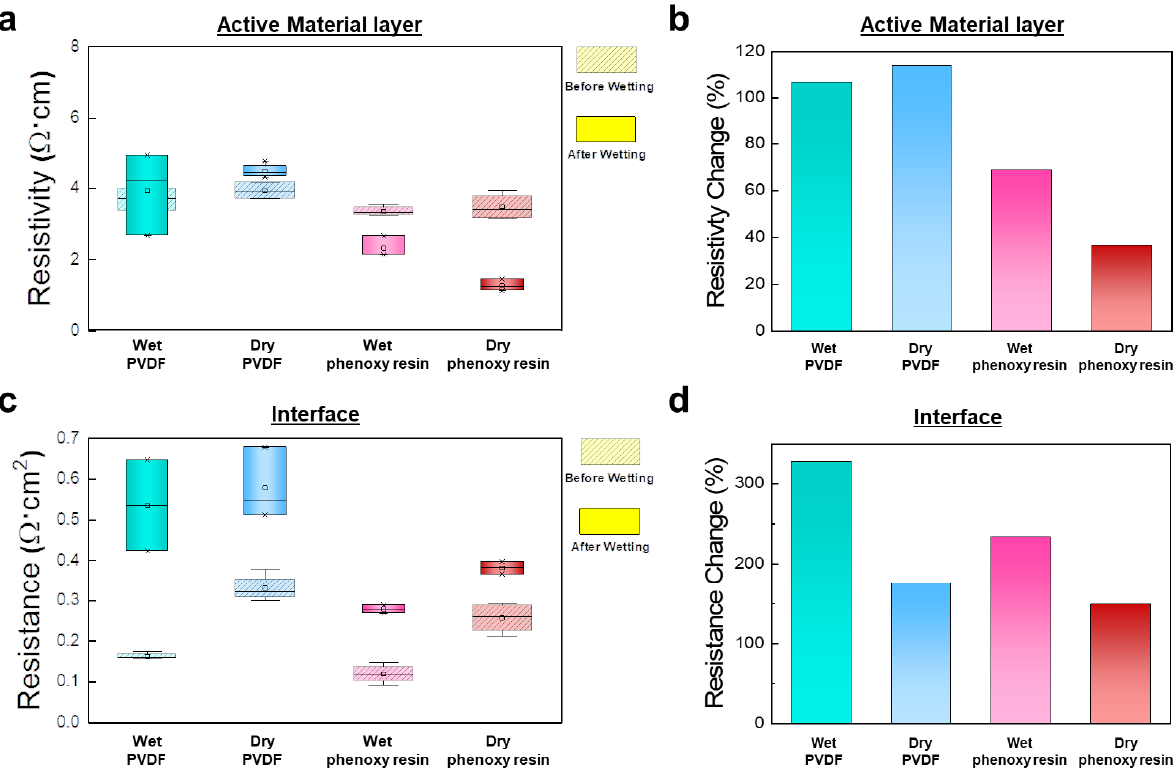
Figure 4. Resistivity of the active material ( a ) and Resistance of the interface ( c ) of the wet PVDF, dry PVDF, wet phenoxy resin, and dry phenoxy resin. Resistivity change of the active material ( b ) and Resistance change of the interface ( d ) of the wet PVDF, dry PVDF, wet phenoxy resin, and dry phenoxy resin.